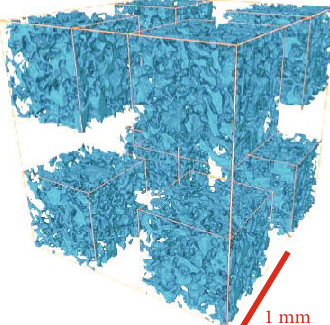
Figure 3: Illustration of the subsampling method in the digital Bentheimer sample. Subsample volumes shown are 300 3 voxels (1 mm 3 ). Only eight corner subsamples are shown in blue for better